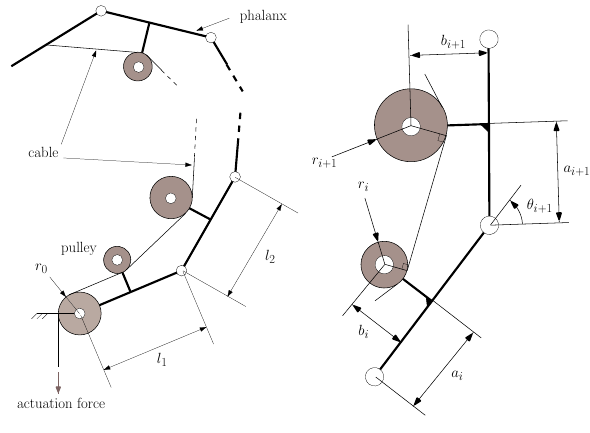
Figure 3. Mechanical wing from Da Vinci’s Codex Atlanticus (ca 1496) annotated by the author. Figure 4. Da Vinci’s